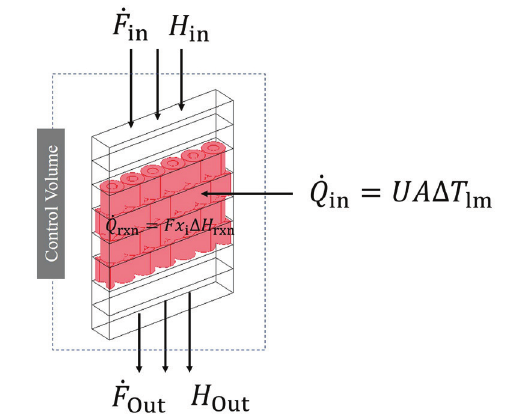
Fig. 10 – Control volume for the energy balance